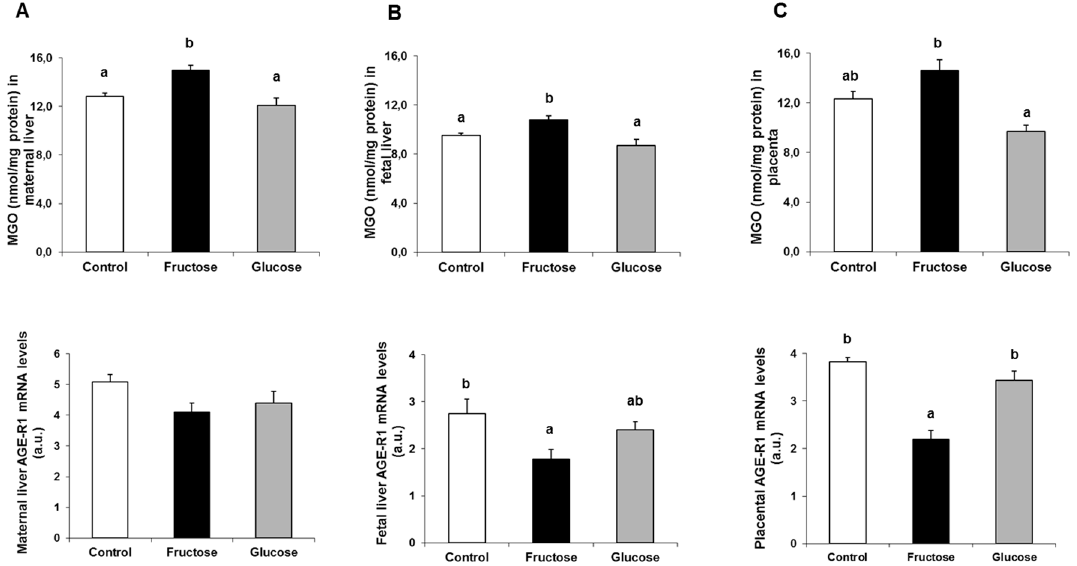
Figure 5. Maternal intake of a 10% w / v fructose solution throughout gestation increases methylglyoxal content in tissues. Bar plots showing the methylglyoxal content (upper panel) and mRNA levels for AGE-R1 gene expression (lower panel) from ( A ) maternal liver, ( B ) fetal liver, and ( C ) placenta of